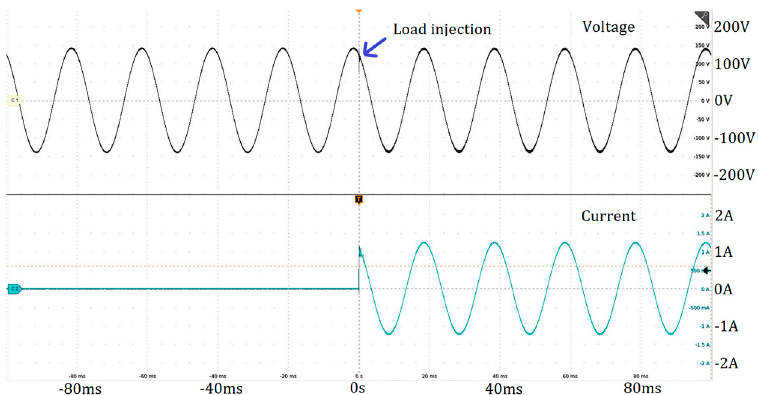
Figure 8. Responses of the stand-alone inverter for AC reference voltage.